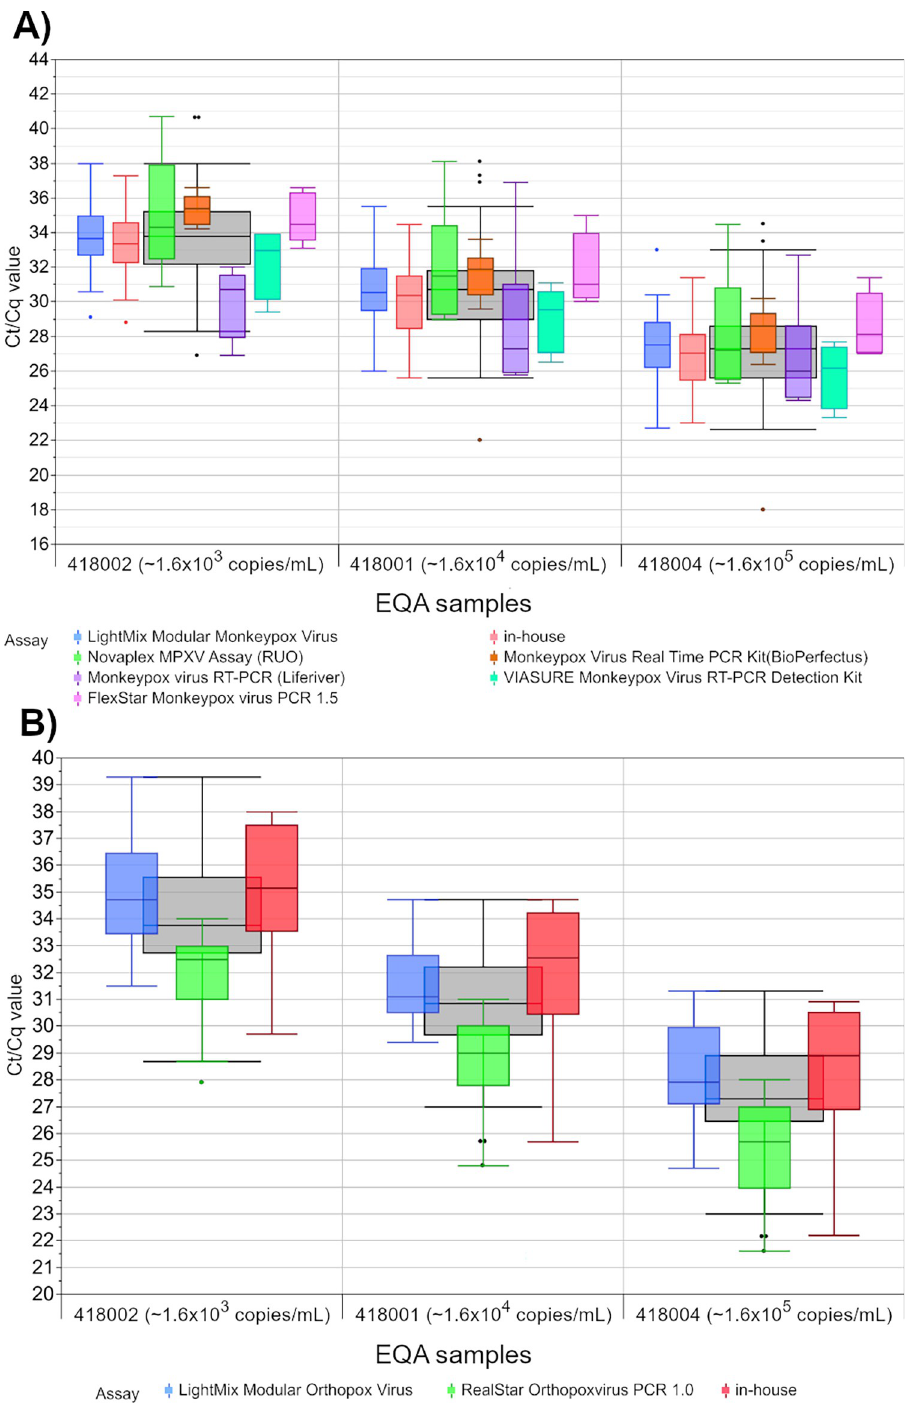
Fig 2. Analysis of Ct/Cq values for (A) monkeypox virus PCR results and (B) for orthopoxvirus PCR results for different test systems. The grey boxes display all results for the respective sample, and the distributions of specific manufacturer-based collectives are illustrated as smaller, colored box plots in overlay with the total results. For all boxes, the whiskers stretch from the 1st quartile—1.5 * (interquartile range) to the 3rd quartile + 1.5 * (interquartile